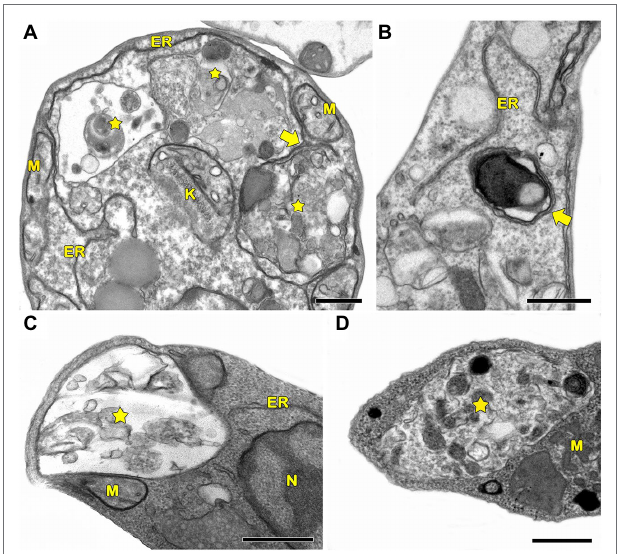
FIGURE 5 | Transmission electron microscopy analysis of autophagic phenotypes conserved in pathogenic trypanosomatids. (A,C) Leishmania braziliensis . (B,D) Trypanosoma cruzi . (A–D) Both parasites treated with drugs showed similar autophagic features such as the presence of autophagosomes (stars) and the formation of endoplasmic reticulum (ER) surrounding organelles (arrows). M, mitochondrion; K, kinetoplast; and N, nucleus. Bars = 0.5 μ